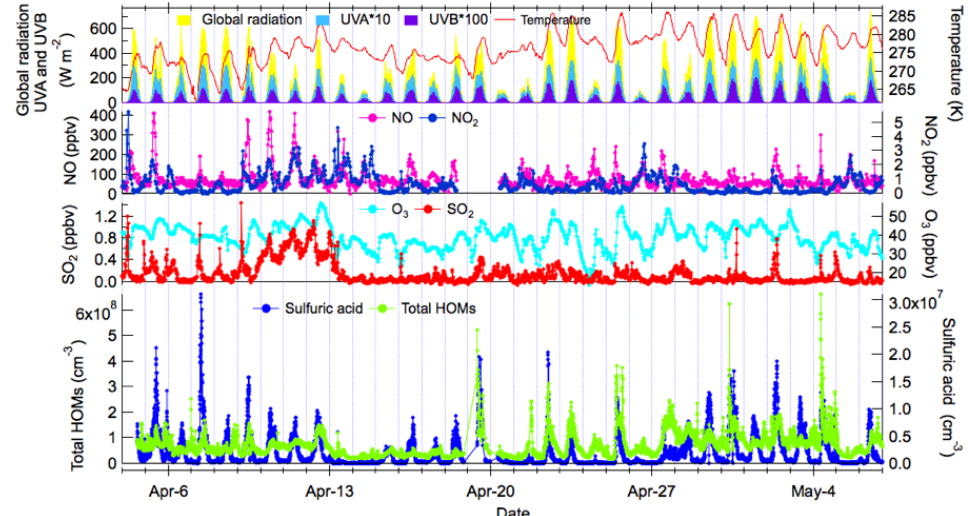
Figure 2. Overview of the measurement from 4 April to 8 May 2012. The top panel shows meteorological parameters, including UVA, UVB, global radiation, and temperature. Co-located measurements of inorganic trace gases, including NO, NO 2 , SO 2 , and O 3 , are shown in middle panels. Highly oxidized species measured by the CI-APi-TOF, i.e., sulfuric acid (SA) and total HOMs, that are shown in the bottom